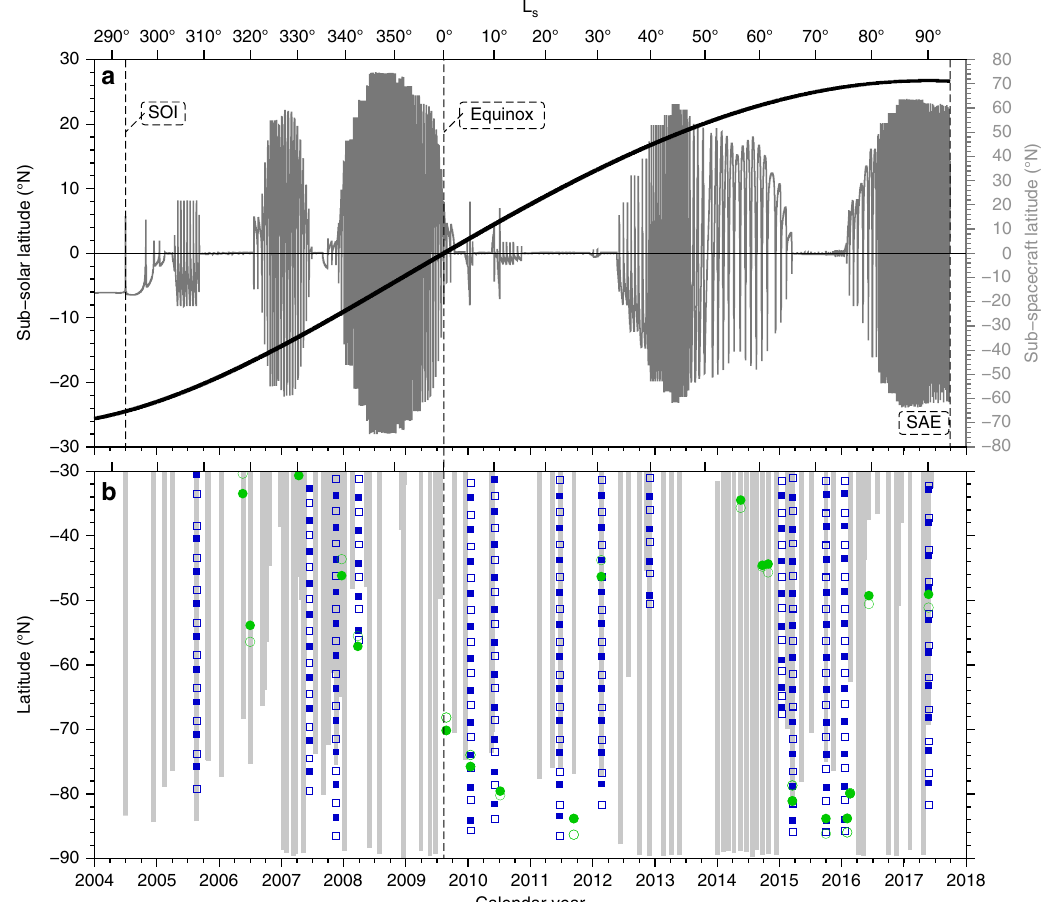
Fig. 1 Cassini orbital information and CIRS data coverage. a Grey line shows the latitude of Cassini ’ s sub-spacecraft point on Saturn as a function of calendar year and solar longitude (L s ). Cassini ’ s complex orbit includes extended periods in Saturn ’ s equatorial plane (sub-spacecraft latitude ~0°) to permit fl ybys of Titan and Saturn ’ s other icy moons, but also includes signi fi cant portions with high orbital inclination to permit mapping of polar regions of Saturn, rings and moons. Thick black line shows evolution of sub-solar latitude during the Cassini mission, from southern summer at Saturn orbit insertion (SOI), through the northern spring equinox in August 2009, to northern summer solstice near saturn atmospheric entry (SAE) at the end of the mission in September 2017. b Coverage of southern hemisphere CIRS nadir and limb data. Nadir 2.5 cm − 1 mapping coverage shown by grey vertical bars; limb 0.5 cm − 1 integrations shown by solid/open green squares for FP3/FP4, respectively; and limb 14 cm − 1 cross-section maps shown by solid/open blue squares for FP3/FP4, respectively. Due to orbital constraints on viewing geometry, nadir and limb data have complementary coverage of the south polar region. The high spectral resolution 0.5 cm − 1 limb integrations (green) have the best signal-to-noise and altitude information, but have limited spatial and temporal coverage except around